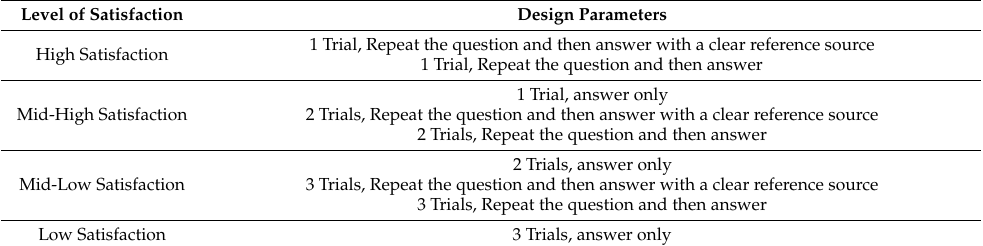
Table 5. Classification of emotional satisfaction of voice-based intelligent